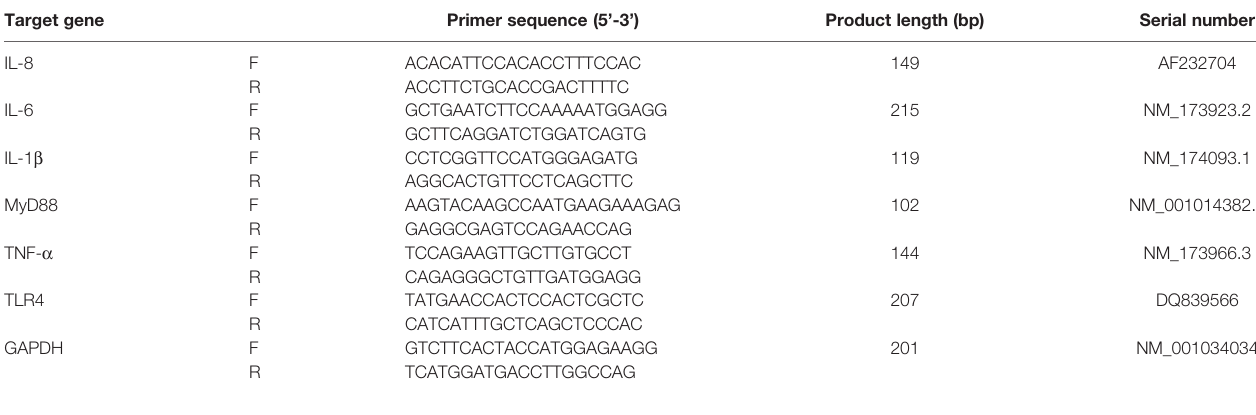
TABLE 1 | Target gene primer sequence, ampli fi ed fragment length, and sequence number. Target